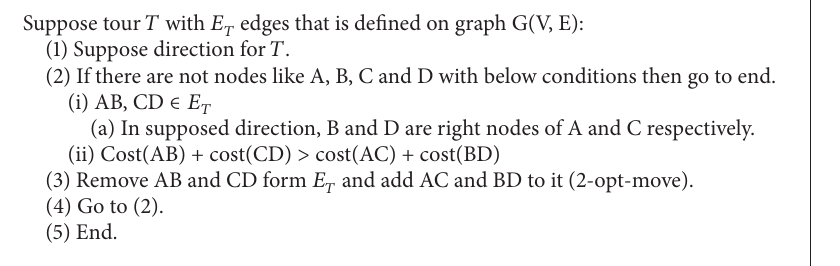
Algorithm 1: General algorithm for 2-opt.